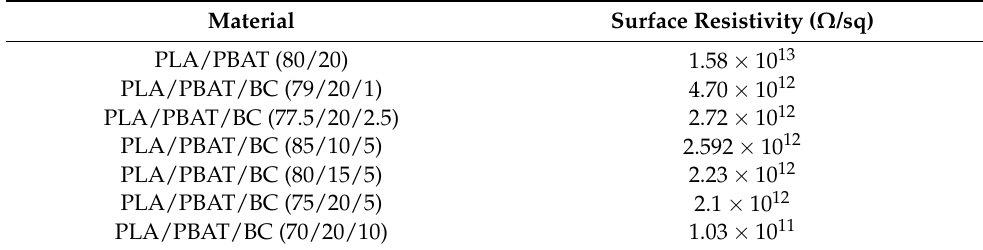
Table 4. Surface resistivity of PLA/PBAT/BC